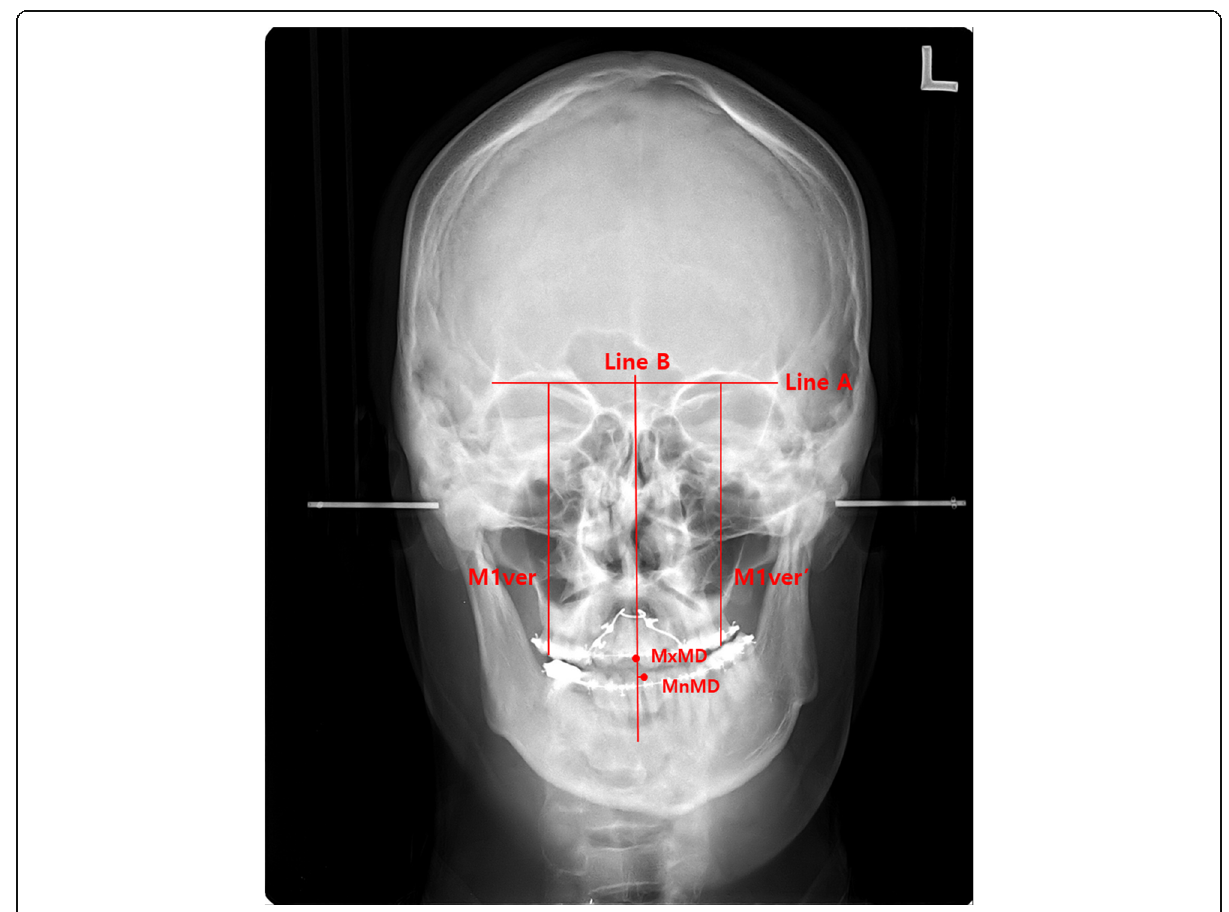
Fig. 1 Evaluation with P-A cephalograms for maxillary, mandibular midline deviation, and maxillary canting. Line A: horizontal reference line between the right and left lateral orbitale. Line B: facial midline perpendicular to line A and through the midpoint of line A. MxMD: the amount of maxillary midline deviation between line A and the maxillary dental midline. MnMD: the amount of mandibular midline deviation between line A and the mandibular dental midline. M1ver: the vertical height of the maxillary right first molar using the most latero-inferior point of the orthodontic tube. M1ver`: the vertical height of the maxillary left first molar using the most latero-inferior point of the orthodontic tube and the amount of maxillary canting, that is, the difference between M1ver and M1ver